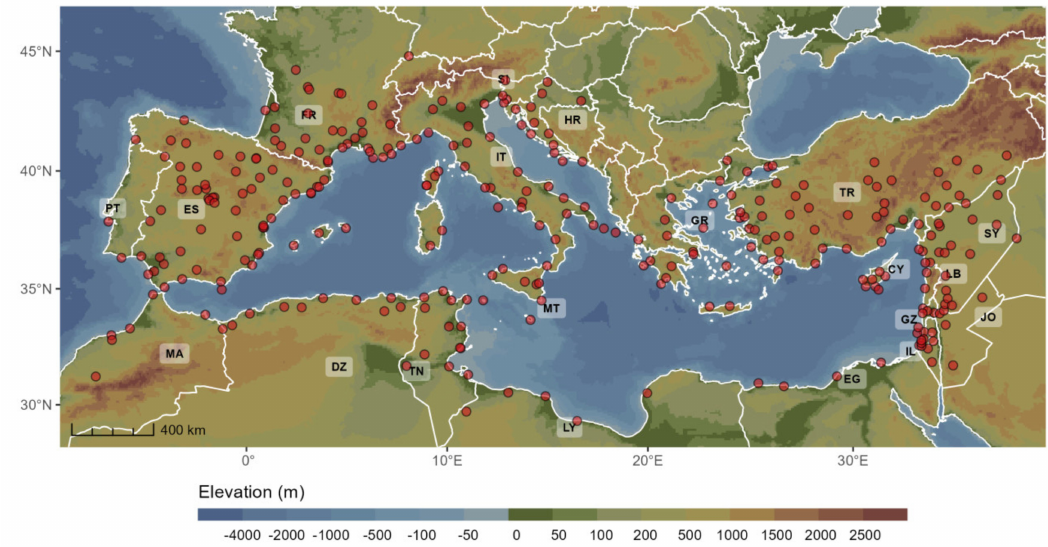
Figure 1. Geographical location map of meteorological stations with continuous monthly precipitation and temperature records in the Mediterranean Basin (MED) over the 1975–2019